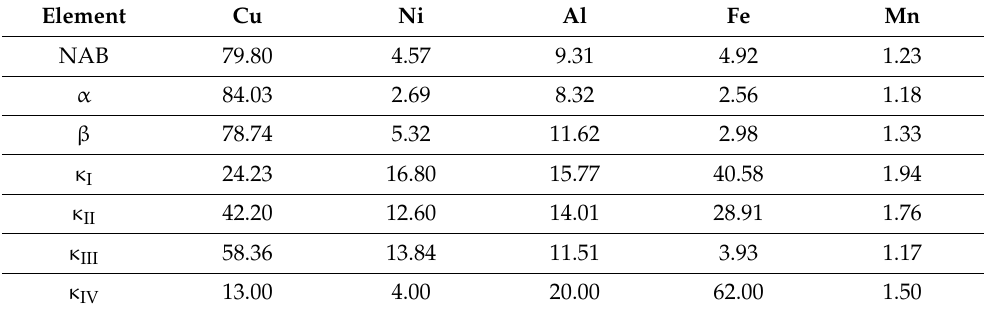
Table 3. Batch analysis data of NAB alloy (as-received) and the composition of the phases from EDS analysis (wt.%) in the AR state. Data for κ IV were taken from literature [30] for comparison. Element